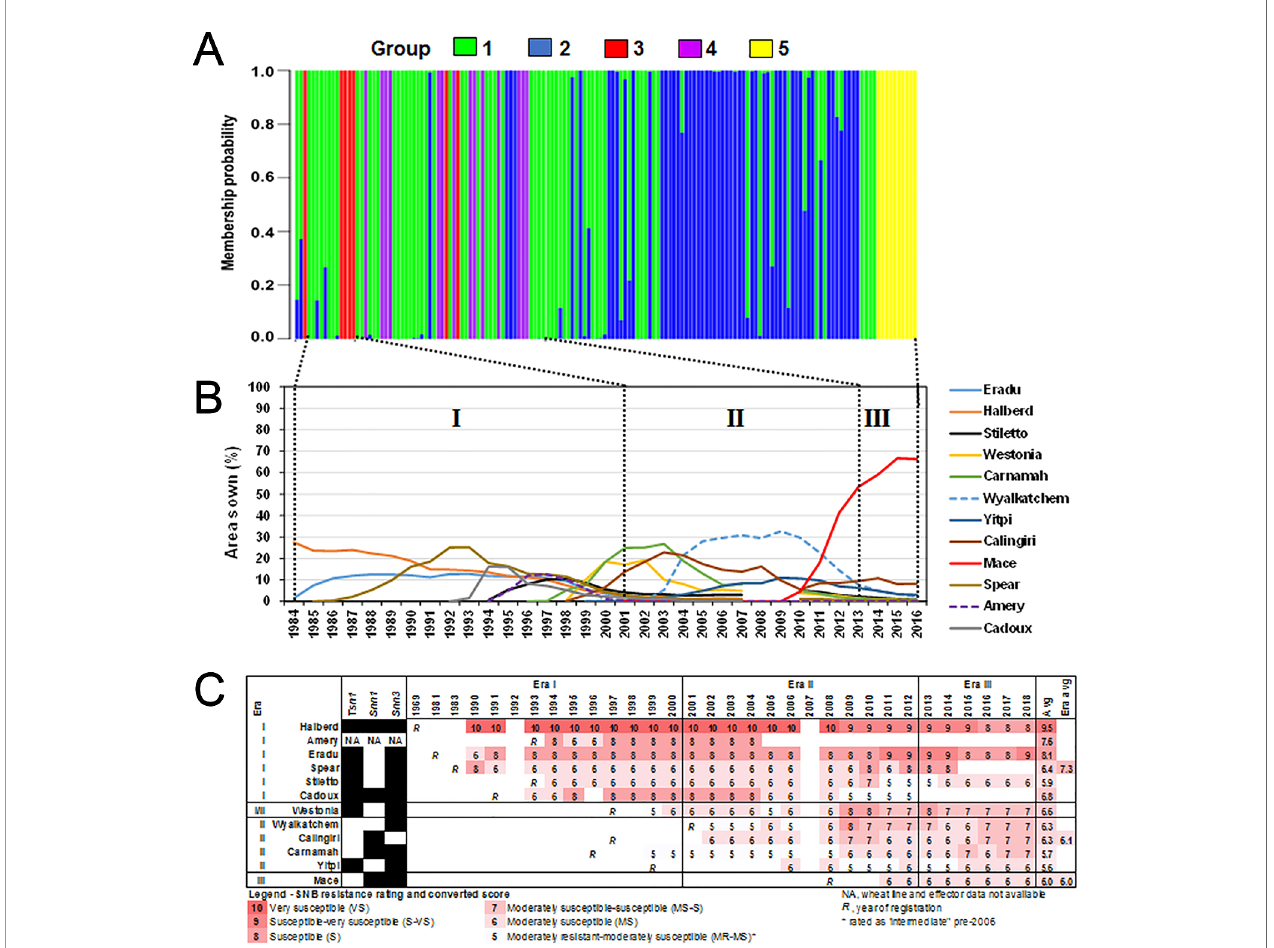
FIGURE 6 | Shifts in the P. nodorum population structure over time using (A) discriminant analysis of principal components (DAPC) membership probability. Isolates were arranged in chronological order from 1976 (left) to 2016 (right). (B) Major wheats sown in WA between 1984 – 2016 (CBH Group, Australia). Wheats grown on at least 10% of the total area sown in any given year were shown. Roman numerals indicate designated eras of major changes in wheat cultivar adoption coinciding with shifts in the P. nodorum population. (C) SNB resistance rating of major wheats from 1990 to 2018 (DPIRD,